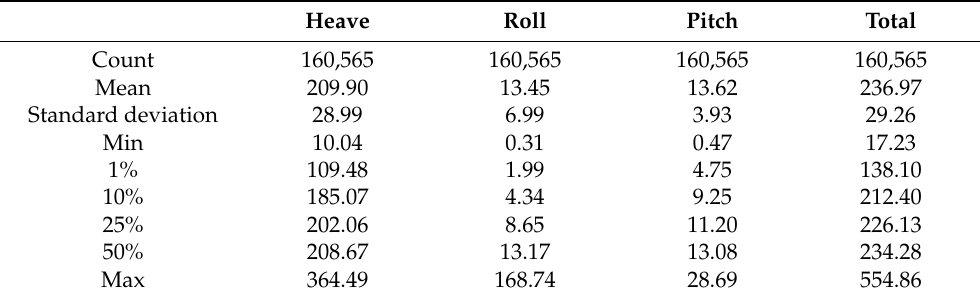
Table 3. Statistics on the distribution of RMSE values of case HS405HA070_SS05WA270 .